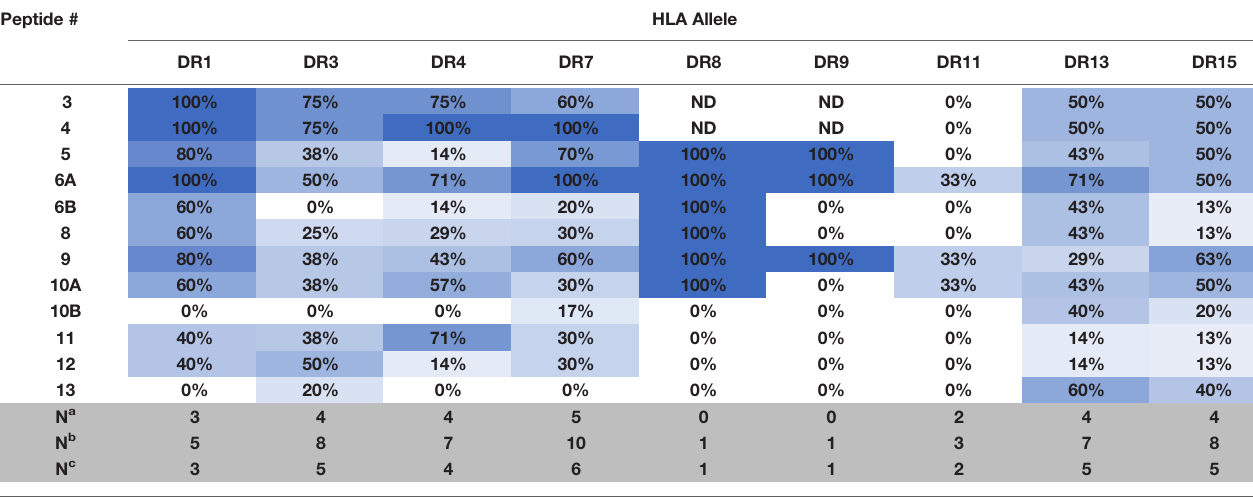
TABLE 2 | High percentages of VAC063 donors, by matched HLA-DR allele, recall RH5 class II epitope clusters located in the N-terminal region of the protein.